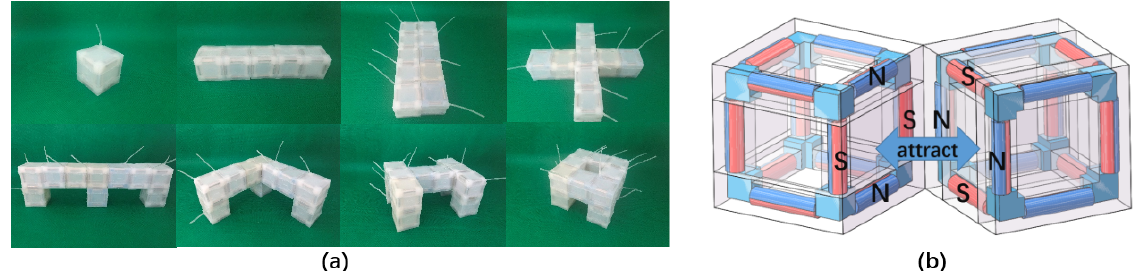
Figure 2. ( a ) Various configurations of soft modular robots. ( b ) The connection schematic of soft